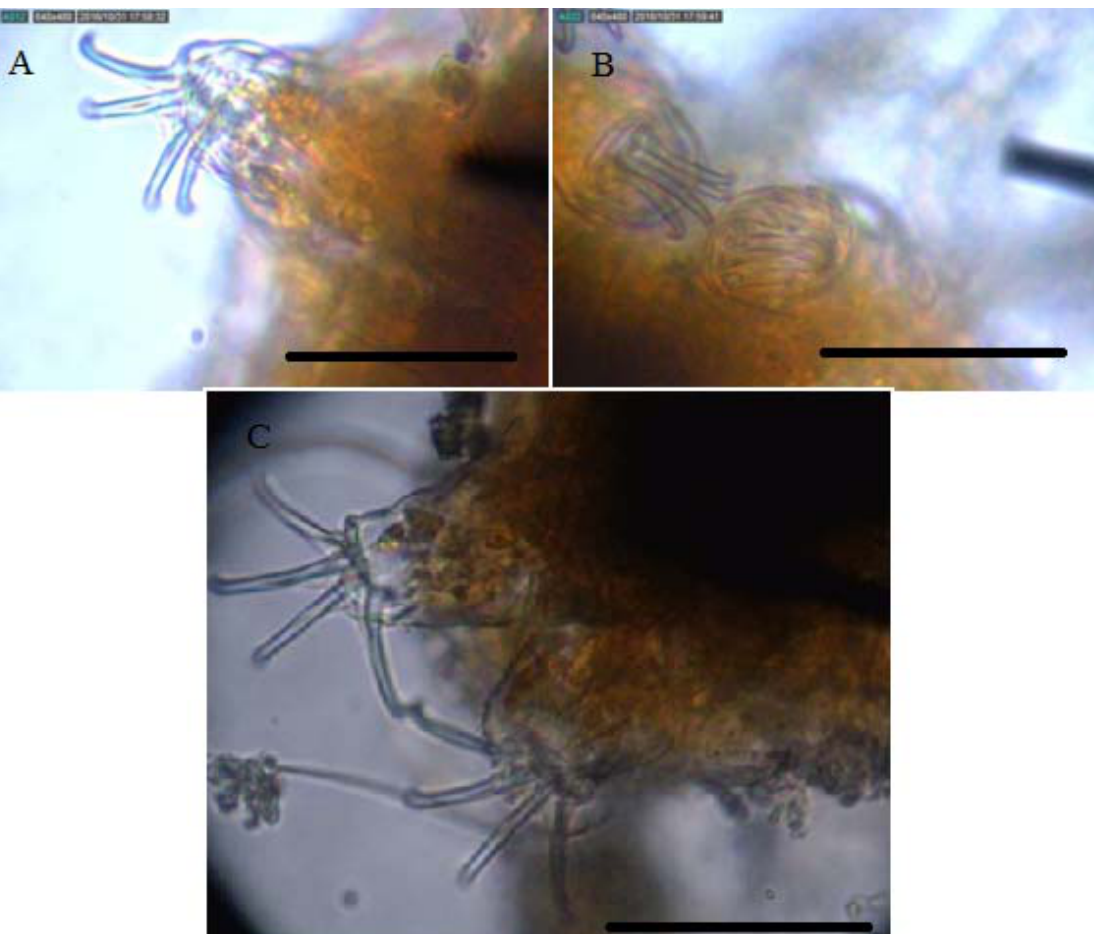
F IGURE 5. General morphology of E. testudo claws. Scale bars equal 25 μ m (A) First legs (B) Second legs (C) Thirty